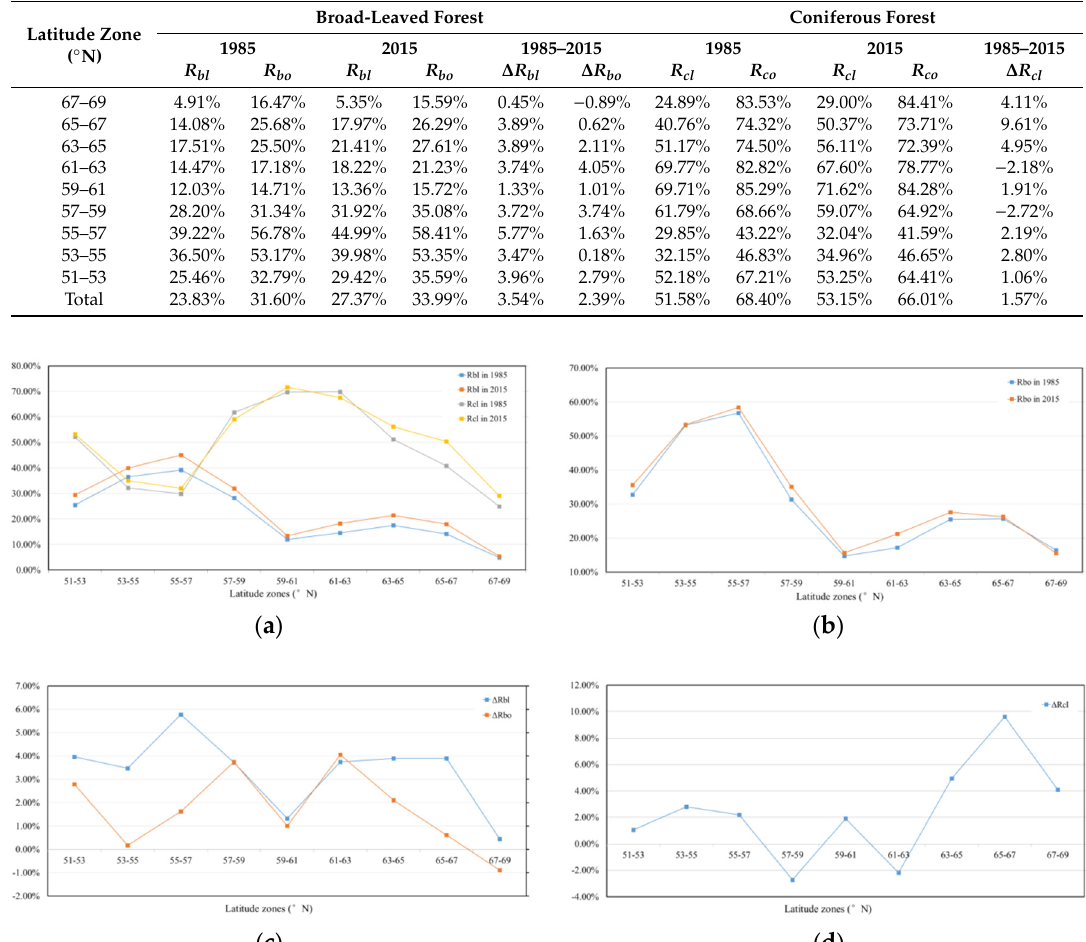
Table 4. Broad-leaved forest area.